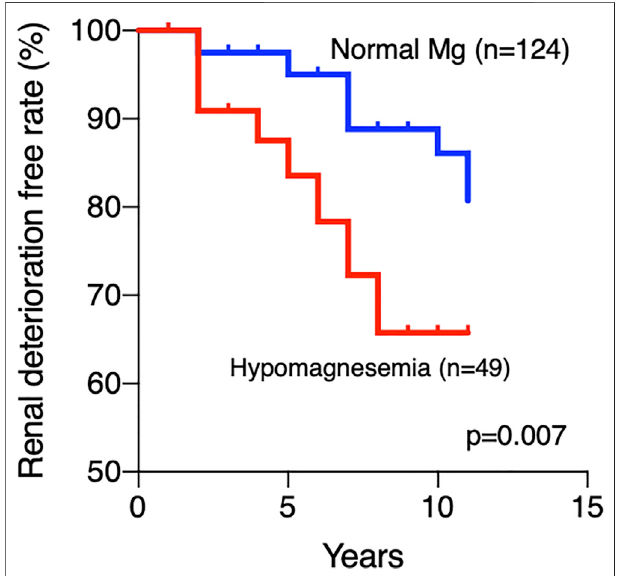
FIGURE4| Cumulative renal deterioration-freerate. Asigni fi cantly lower renal deterioration-free rate was observed in patients with hypomagnesemia than in patients with normal Mg levels ( p (cid:1) 0.007) Mg, magnesium.